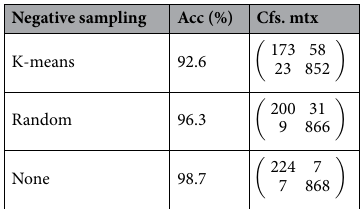
Table 1. Binary (tumor vs. no tumor) classification accuracies on BreastPathQ test set with different negative sampling schemes using minority oversampling.